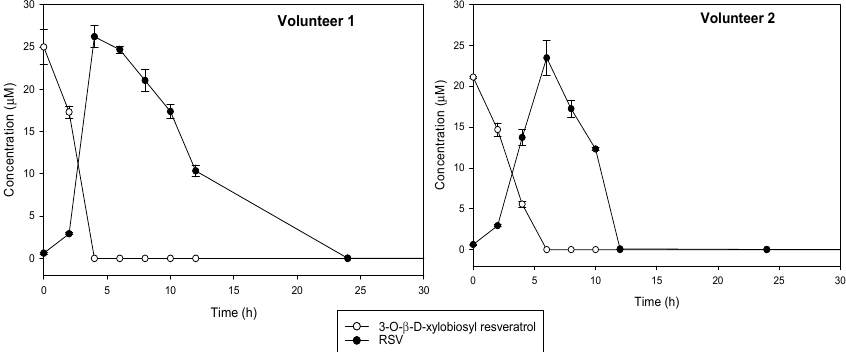
Figure 5. Kinetics of in vitro conversion under anaerobic conditions of 3- O - β - D -xylobiosyl resveratrol (white dots) into trans -resveratrol (RSV, black dots) by fecal microbiota from two different healthy volunteers.